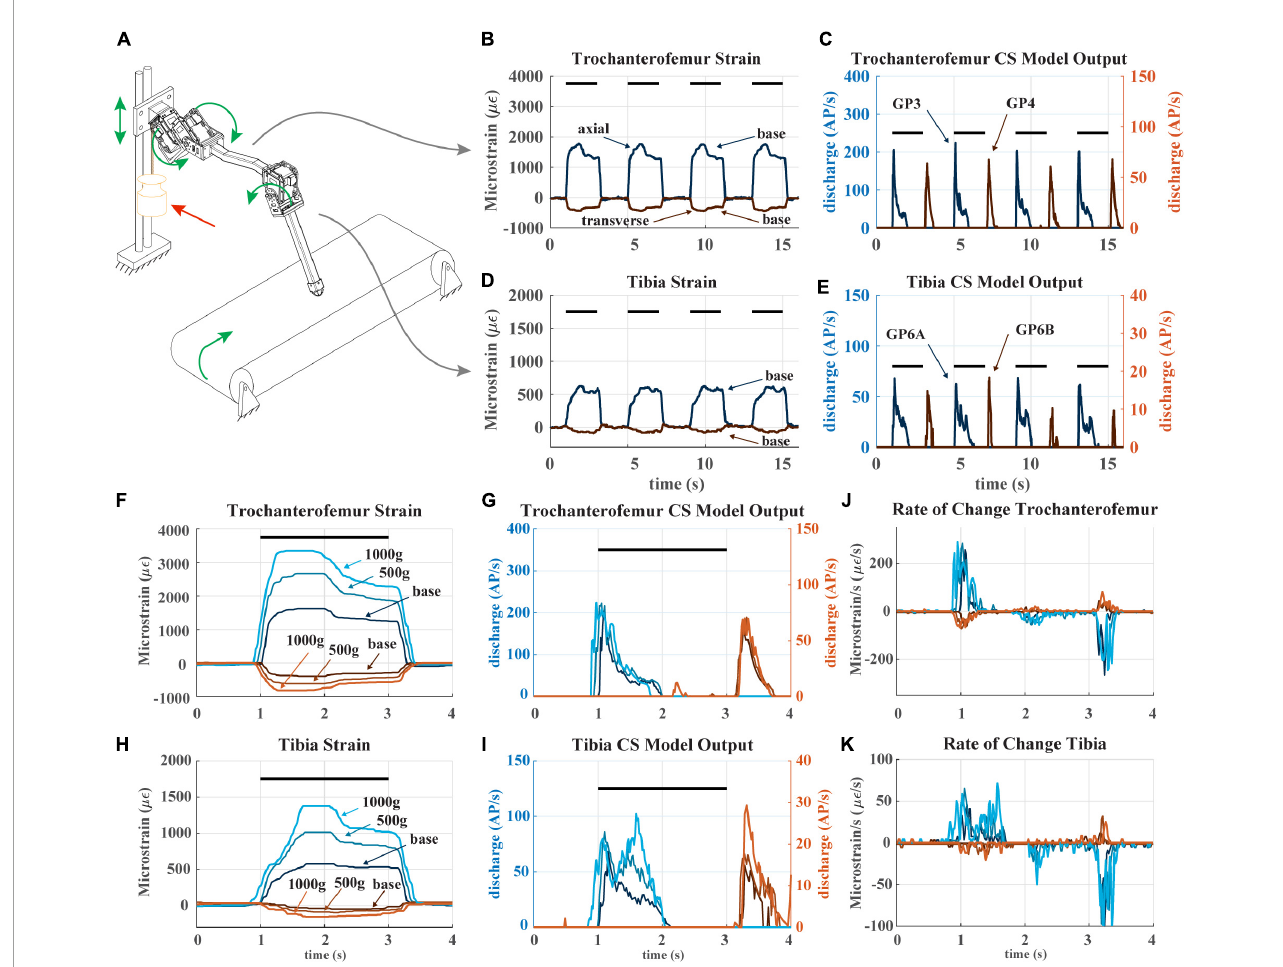
FIGURE6 (A) Diagram of robotic leg configuration. Green arrows show type and direction of movement for the servomotors, linear guide, and treadmill. A weight indicated by the red arrow can be added to the linear guide to simulate additional body weight. (B) The raw trochanterofemur strain data of four subsequent steps in baseline configuration (no added weight). The axial strain is indicated in shades of blue and transverse indicated in shades of red. Positive changes in values indicate compression in that direction; negative changes in values indicate tension in that direction. The black bars indicate stance phase. (C) The trochanterofemur (group 3 and 4) CS model discharge from four subsequent steps in baseline configuration. (D) The tibial strain data from the same four subsequent steps (E) : The tibia CS model discharge (group 6B and 6A) from four subsequent steps in baseline configuration. (F) The raw trochanterofemur strain from individual steps in each of the three load configurations. The configurations are baseline (no added weight), 500 g configuration (added weight to linear guide), and 1,000 g configuration (added weight to linear guide). (G) The CS model discharge of